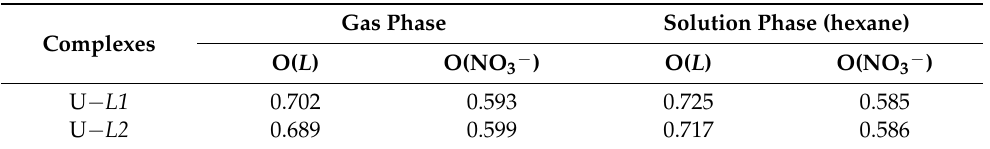
Table 3. Wiberg Bond Indices (WBIs) at the B3LYP/ECP60MWB/6-311g(d,p) level of theory in both gas phase and solution phase.